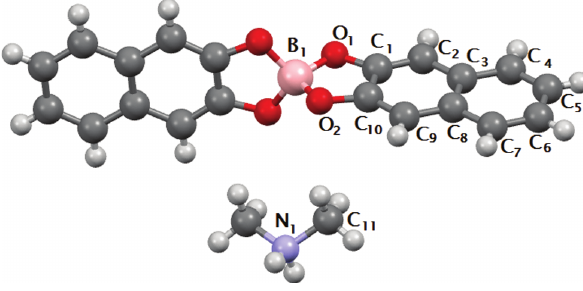
Table 1: Data collection and